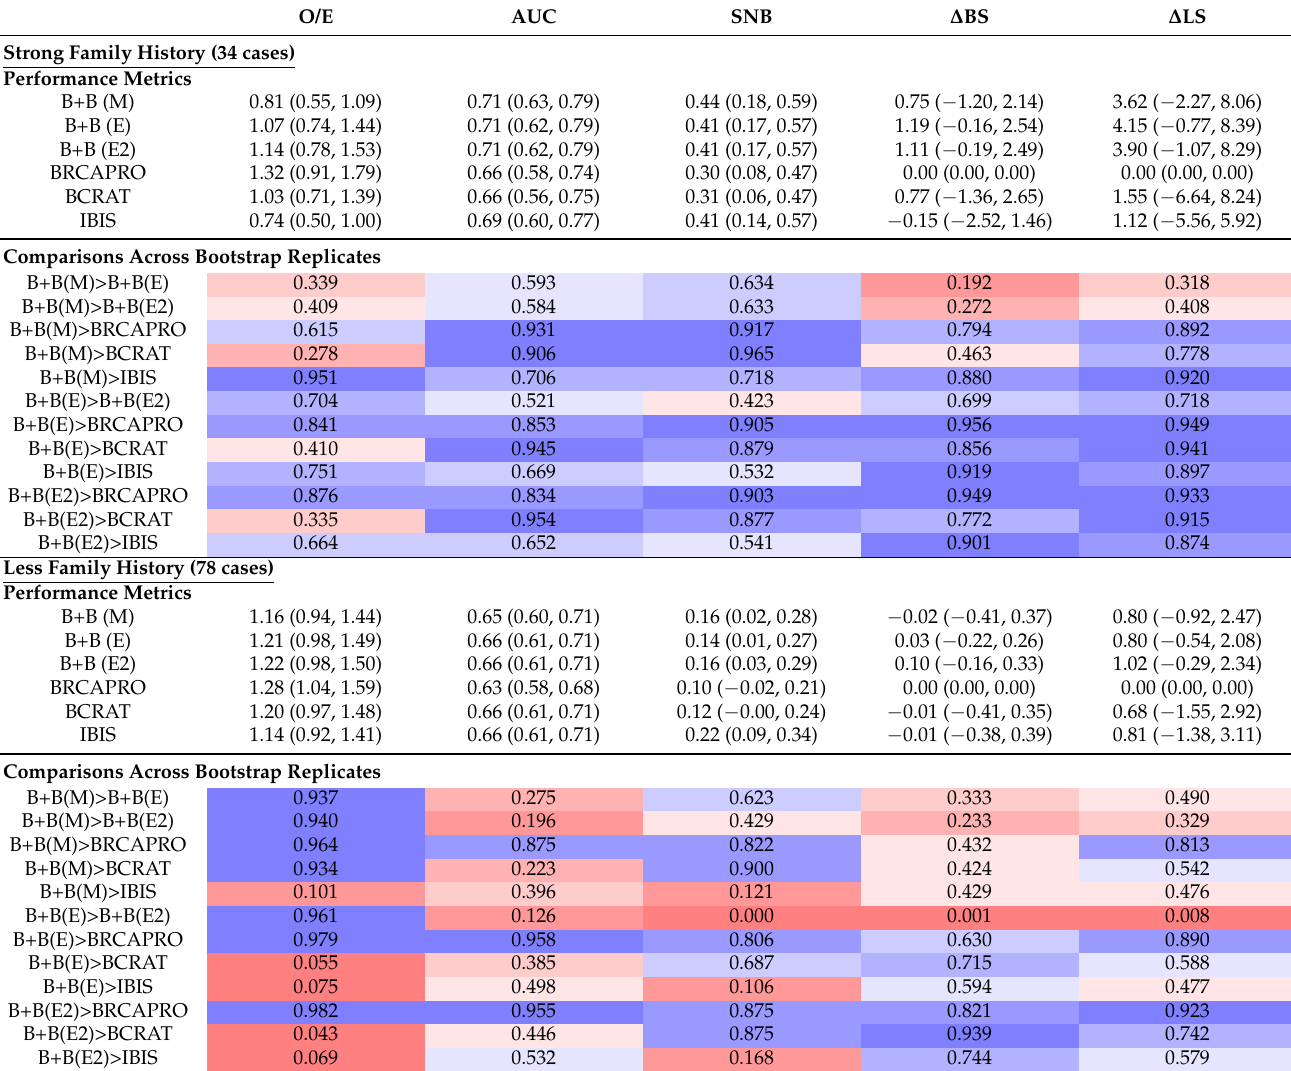
Table 4. Five-year performance in the CGN cohort stratified by family history (whether or not the proband met the NCCN criteria for further genetic risk evaluation [55]; in applying the criteria, we only used information on breast and ovarian cancer diagnoses in relatives). B+B: BRCAPRO + BCRAT. ∆ BS: % relative improvement in Brier Score compared to BRCAPRO. The “Comparisons Across Bootstrap Replicates” section shows pairwise comparisons involving the combination models across 1000 bootstrap replicates of the validation dataset; the row for A > B shows the proportion of bootstrap replicates where model A outperformed model B with respect to each metric. Proportions > 0.5 are highlighted in blue (with darker shades of blue for higher proportions) and proportions ≤ 0.5 are highlighted in red (with darker shades of red for lower